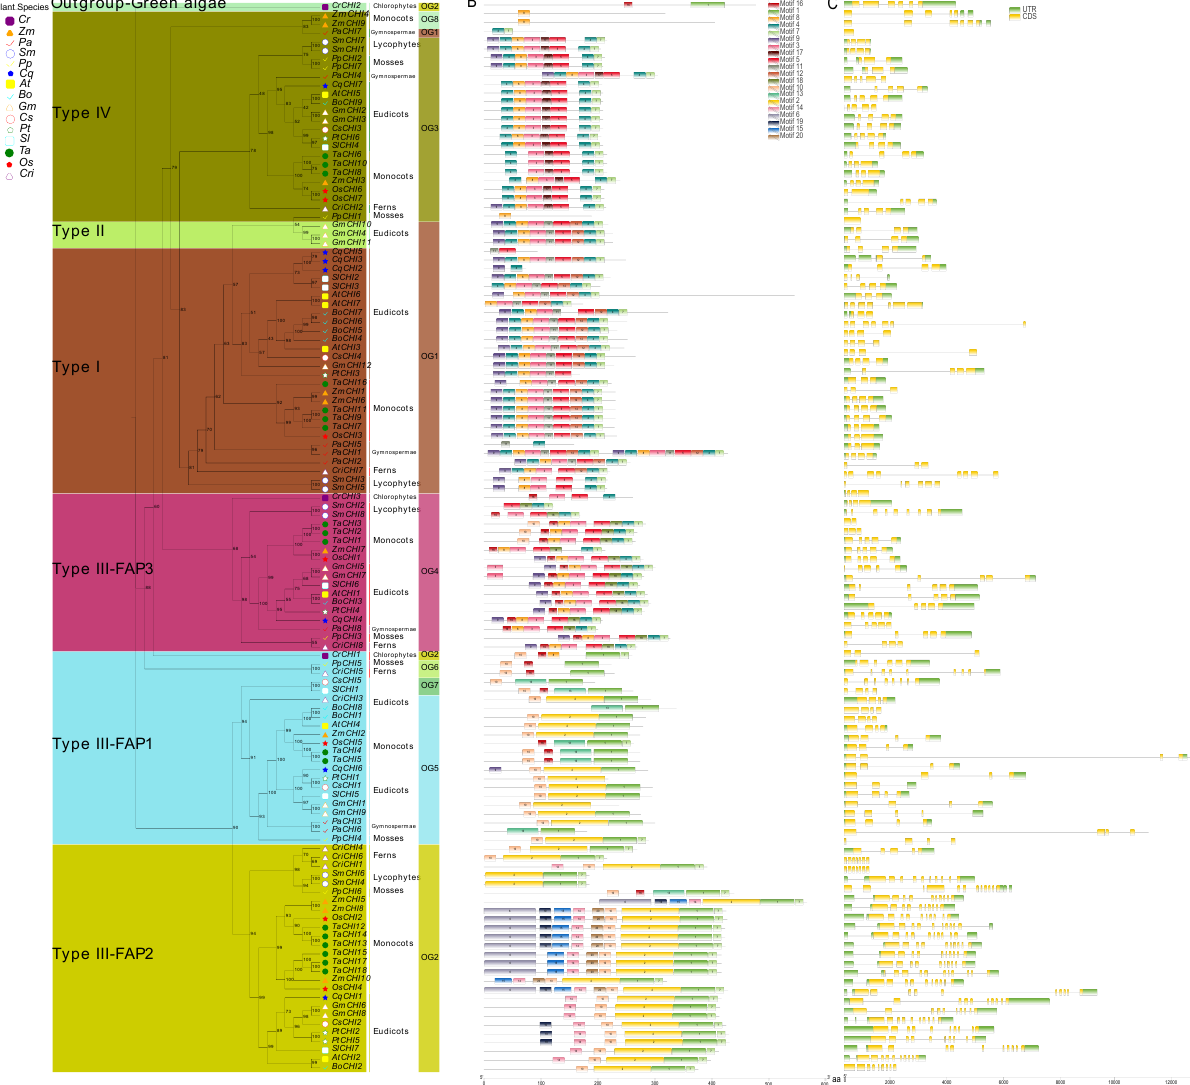
Figure 2. Phylogenetic relationships and genomic structures of green plant CHI genes. ( A ) A phylogenetic tree of plant CHI genes was built displaying the evolutionary history of these genes. The maximum likelihood (ML) phylogenetic tree was developed using the IQ-TREE tool with 1000 bootstrap replicates. Details of classifications and orthologous groups (OGs) are shown in different colors. Os, Zm, Ta, At, Bo, Cq, Cr, Cs, Gm, Pp, Pt, Sl, Sm, and Cri represent Oryza sativa , Zea mays , Triticum aestivum, Arabidopsis thaliana , Brassica oleracea , Chenopodium quinoa , Chlamydomonas reinhardtii , Cannabis sativa , Glycine max , Physcomitrella patens , Populus trichocarpa , Solanum lycopersicum , Selaginella moellendorffii and Ceratopteris richardii , respectively. ( B ) Motif compositions of plant CHI genes. Differently colored boxes represent different motifs, and the numbers in each box indicates the order of motifs. ( C ) The structure of exon/intron and untranslated regions (UTRs). The green and yellow boxes and grey lines represent exons, UTR and introns, respectively. FAP—fatty acid binding